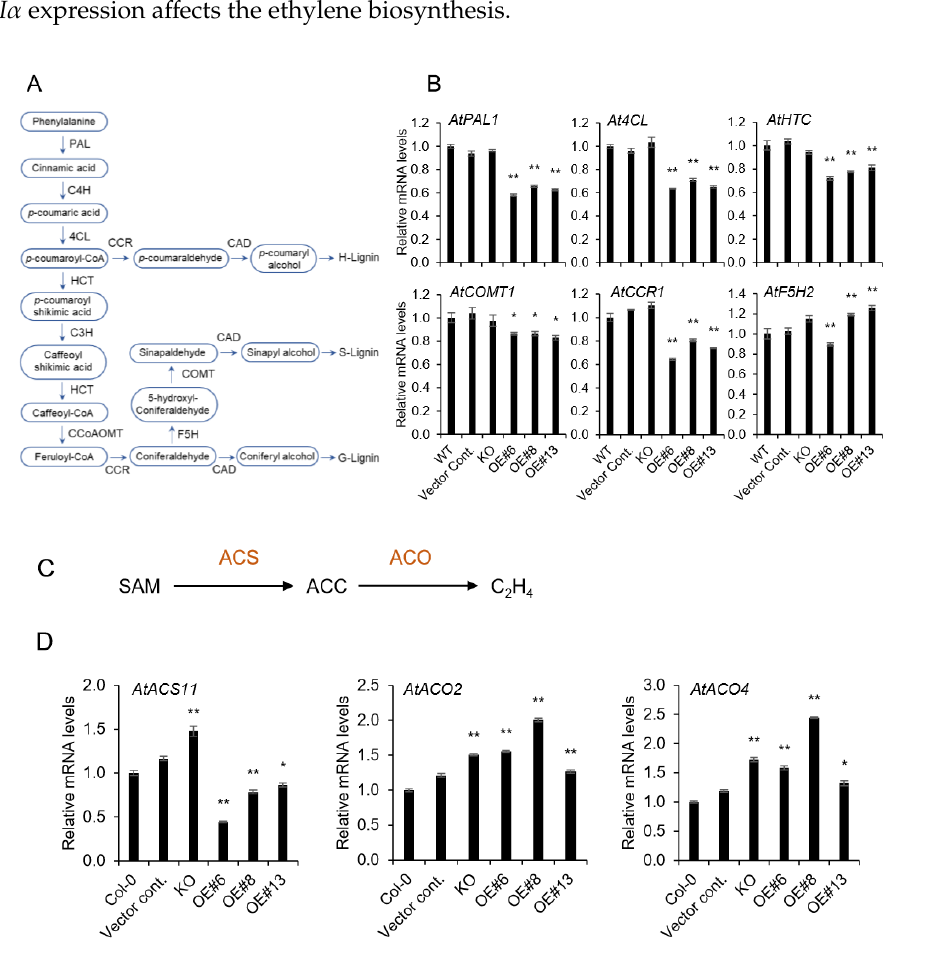
Figure 3. Expression levels of lignin and ethylene biosynthetic genes by qRT-PCR. ( A ) Lignin